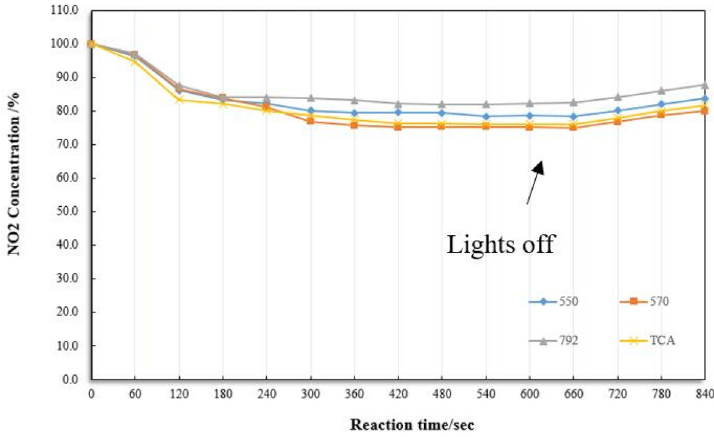
Figure 12. Photocatalytic efficiency of fog seal through different coupling agents.